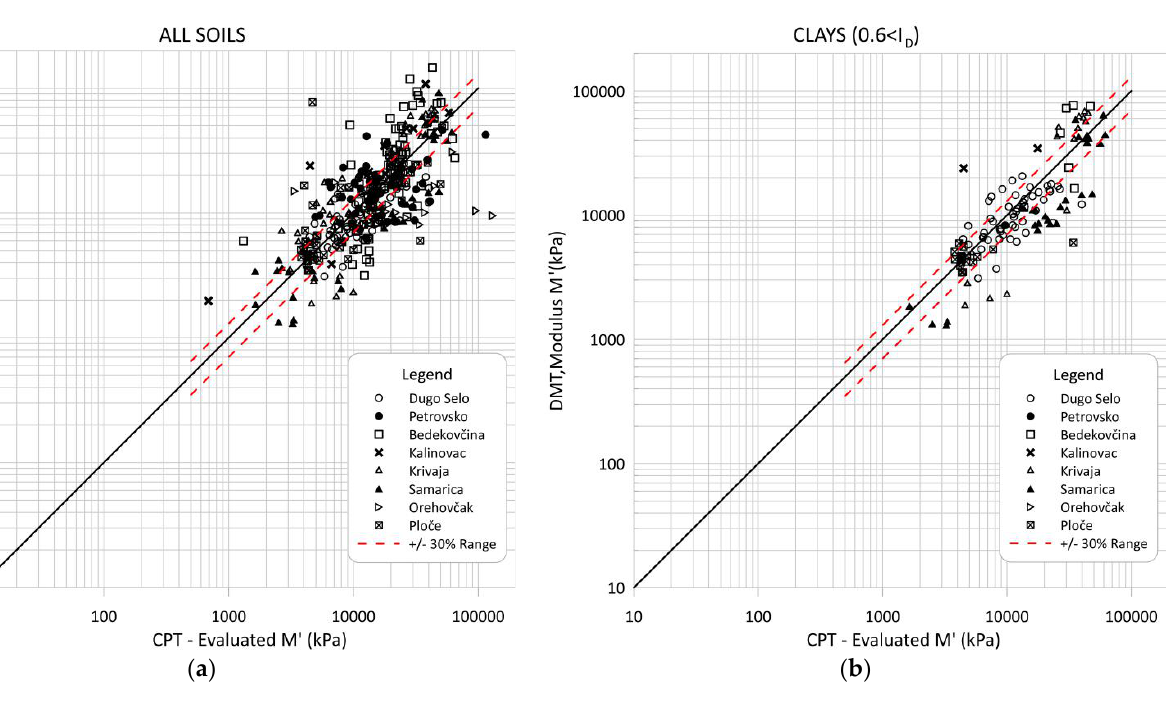
Figure 15. Comparison of CPT evaluated M’ through correlations and constrained modulus M’ DMT from dilatometer data: ( a ) all soils; ( b ) clays.